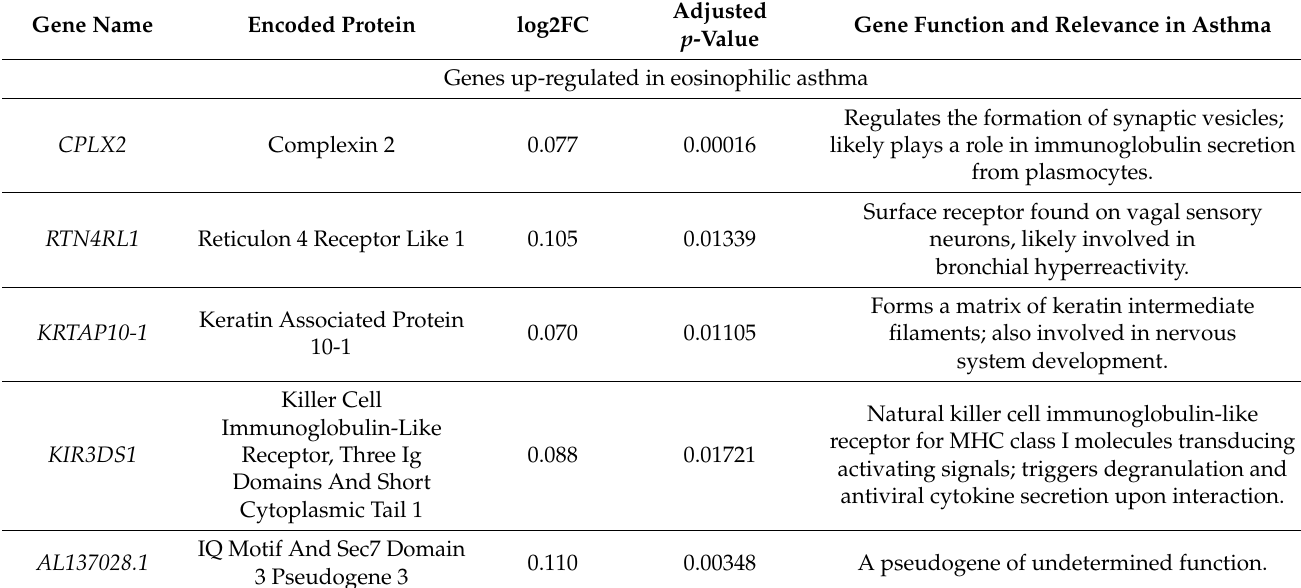
Table 4. Genes differentially expressed in bronchial brush biopsy samples of eosinophilic vs. non- eosinophilic asthma patients adjusted for age, sex, BMI, and oral corticosteroid use. Gene function data obtained from UniProtKB/Swiss-Prot database [15], unless stated